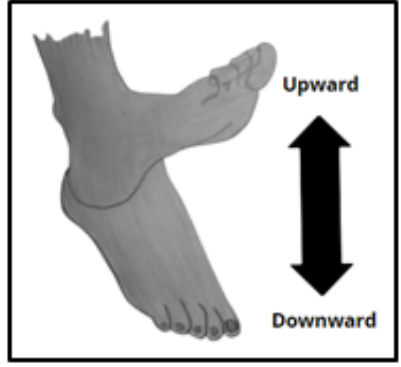
Figure-I: Moving upward and downward to achieve toe taps. Trunk Twist: Sit straight with contracted abs and feet on the floor. Hold shoulder-girdle with opposite hands while arms residing your chest and elbows on sides. Rotate upper-body to right then to left and repeat it several times.